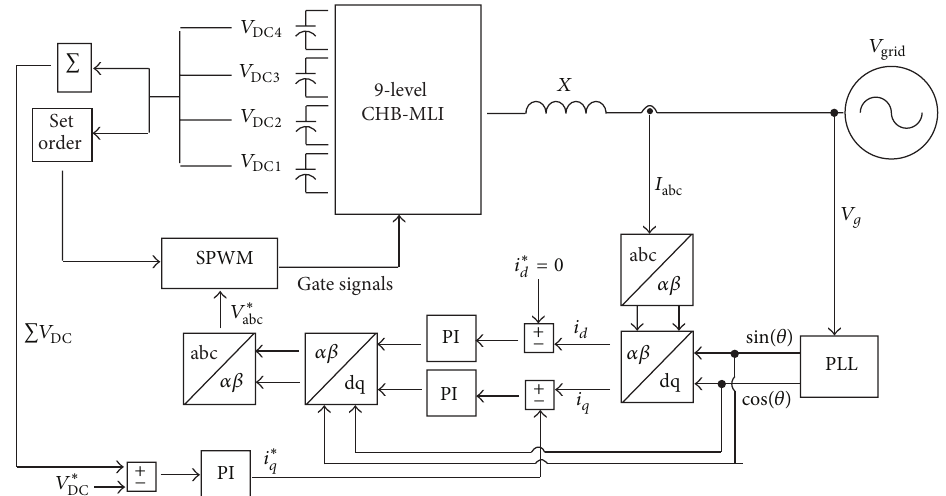
Figure 9: Layout of the control system. The total DC-voltage of each phase leg is controlled by varying 𝑖 𝑞 and thus the load angle to the grid voltage. The individual DC-voltages may be partially controlled by setting the order of conduction of the cascaded H-bridges.